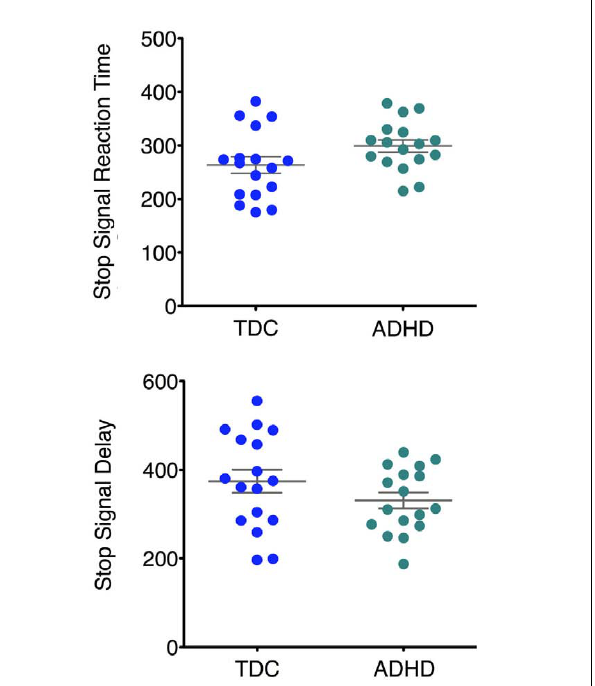
FIGURE 2 | Main effect ofADHD on SSRT ( p < 0.03) and SSD ( p = 0.09). Gray lines indicate mean ±